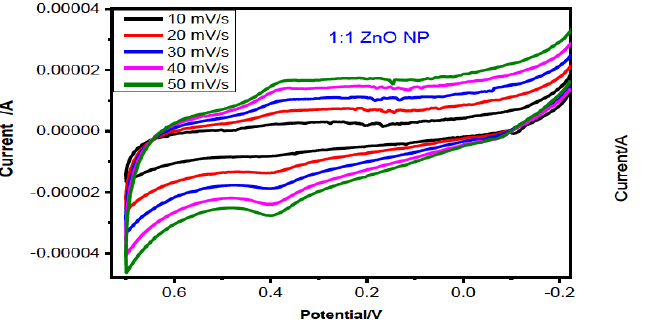
Figure 15: Cyclic voltammogram of 1:1 ZnO NPs.